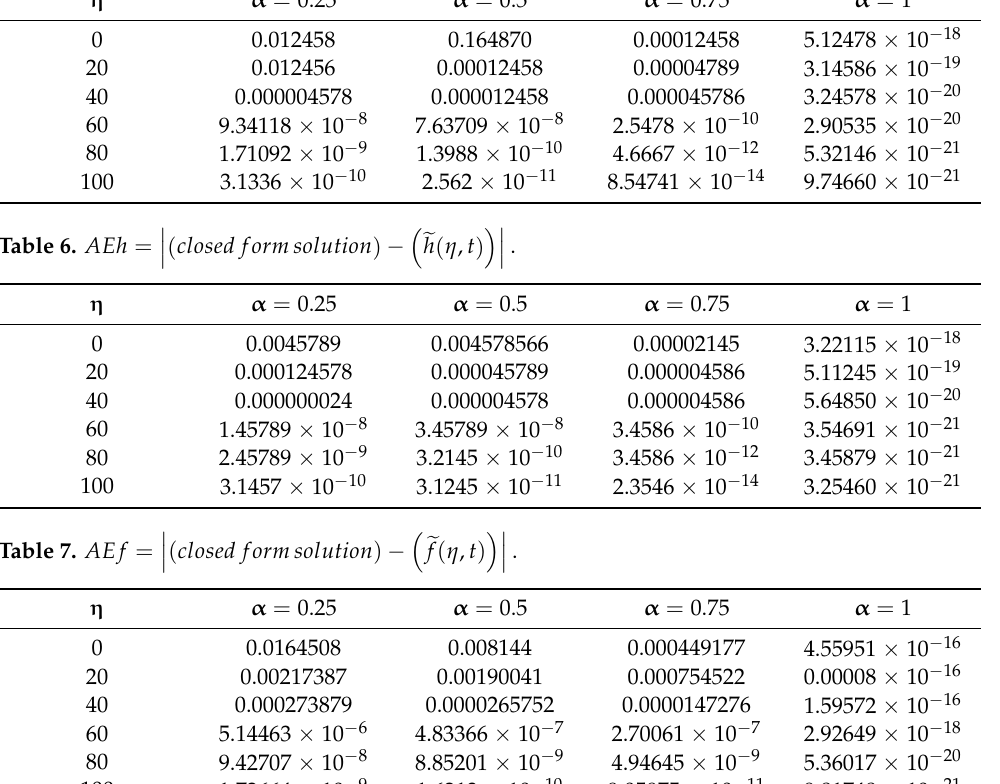
Table 5. AEg = | ( closed form solution ) − ( (cid:101) g ( η , t )) | .